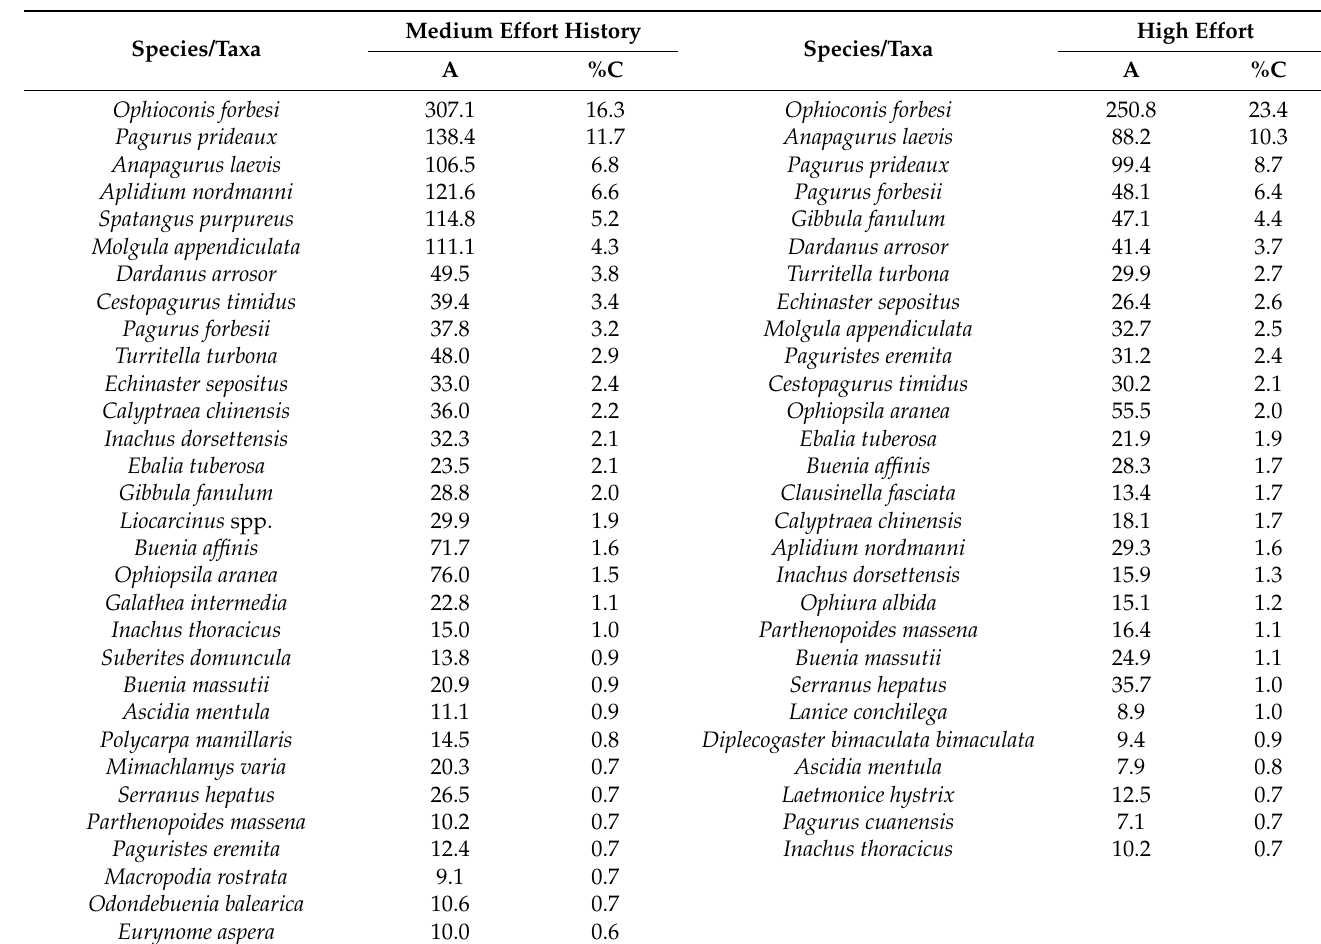
Table 3. Results of SIMPER analysis, estimated from standardized abundance data in beam trawl samples in Medium effort history and High effort areas, showing mean abundance (A; indi- viduals/1000 m 2 ) and percentage contribution (%C) of each species contributing up to 90% of within-group similarity.